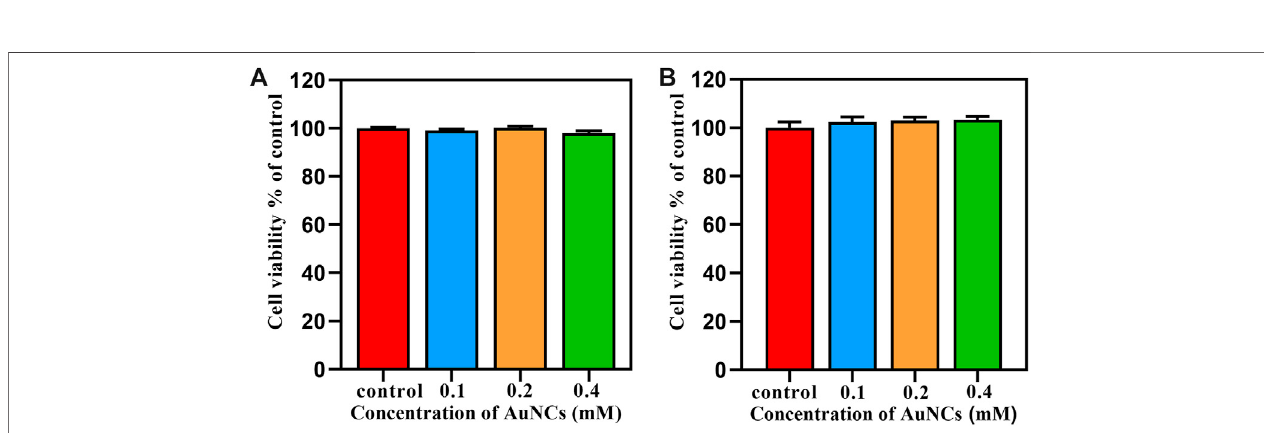
FIGURE 7 | Cytocompatibility assessment of AuNCs on (A) macrophages RAW264.7 and (B) PDLCs by CCK8 at 24 h.